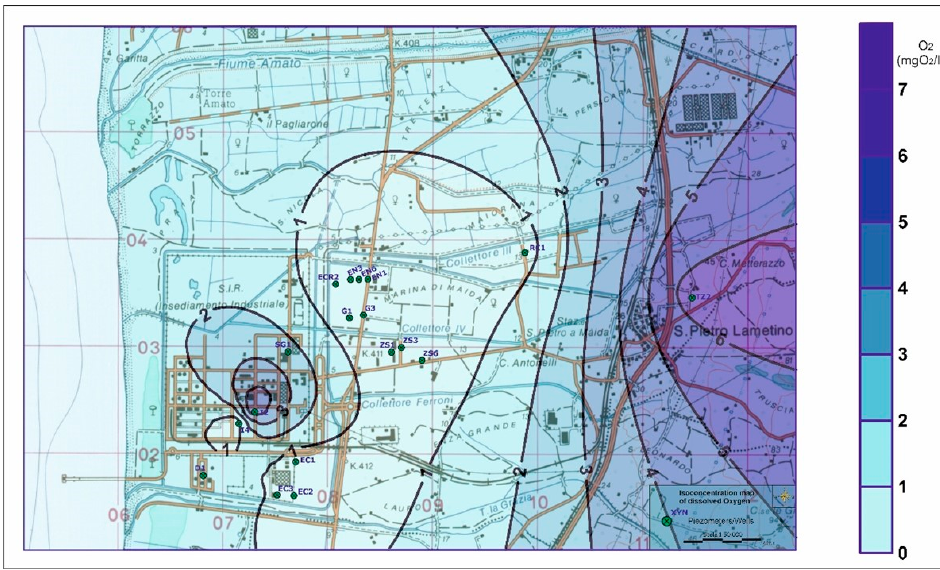
Figure 8. Isodistribution Map of Dissolved Oxygen (Median Values) (Modified) [6].